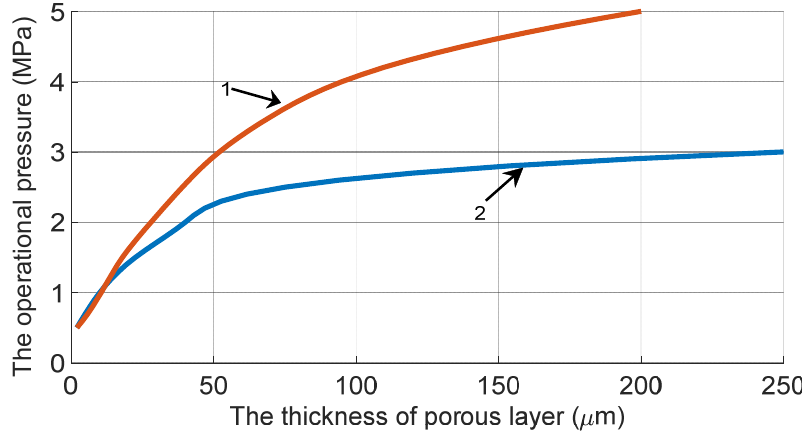
Figure 7. The influence of the porous layer thickness ( h ) on the applied operational pressure ( P max ) selective layer outside (1) and inside (2) the fiber.